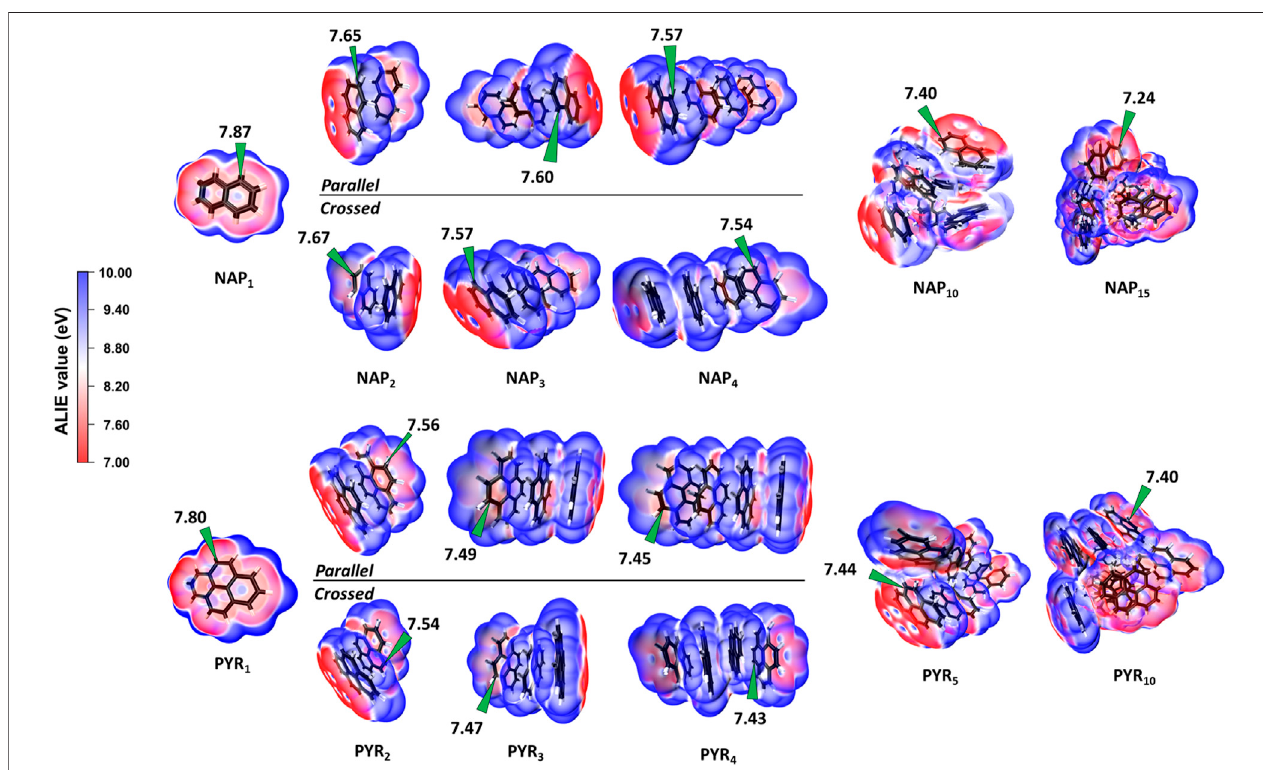
FIGURE 7 | Local ionization energy of NAP and PYR clusters from monomer up to 15 components calculated at the B97D/6-311G(d,p) level of theory. The minimums of ALIE values are highlighted on the plot. The both parallel and crossed con fi gurations are considered for dimers, trimers and tetramers.